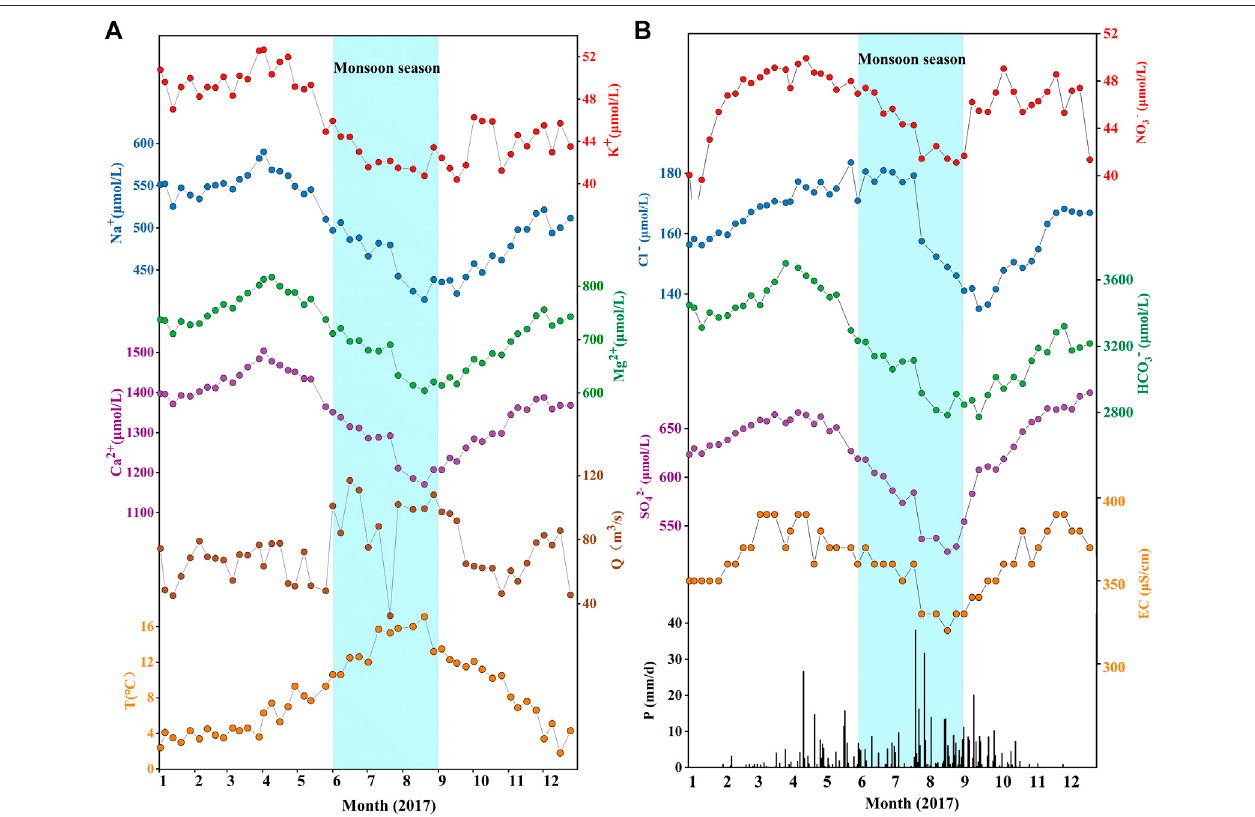
FIGURE 2 | Weekly variations of (A) major cations, (B) major anions and hydrometeorological data in the Datong River monitored at the Qingshizui hydrological station in 2017. (A) Shows the seasonal changes of main cations, water temperature and runoff in the river, and (B) shows the seasonal changes of main anions, conductivityand precipitation intheriver. Themajorionsshow clear seasonal variations, withlowvaluesinrainyseasonand high valuesindryseason.The skybluebars mark the monsoon season.